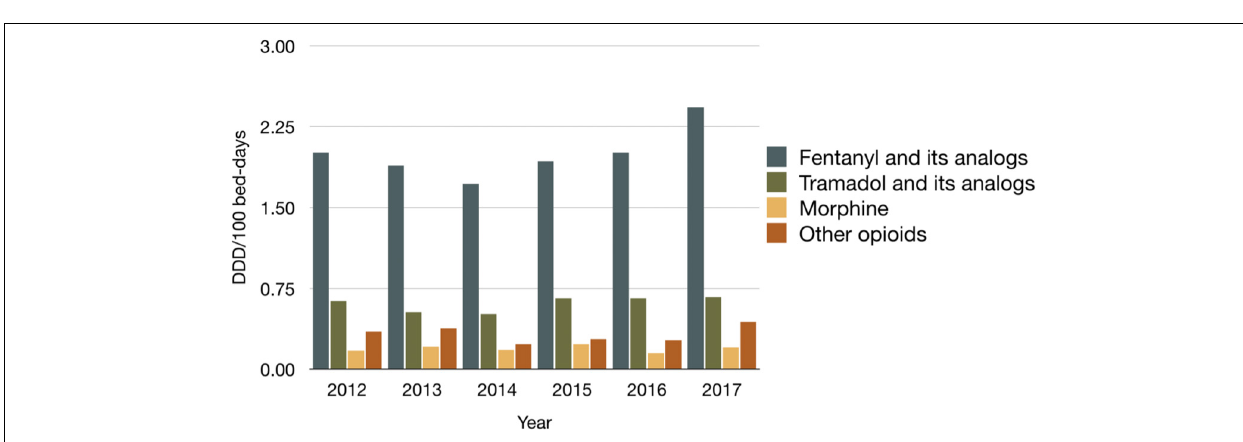
FIGURE 2 | The consumption of all opioids during the 6-year study